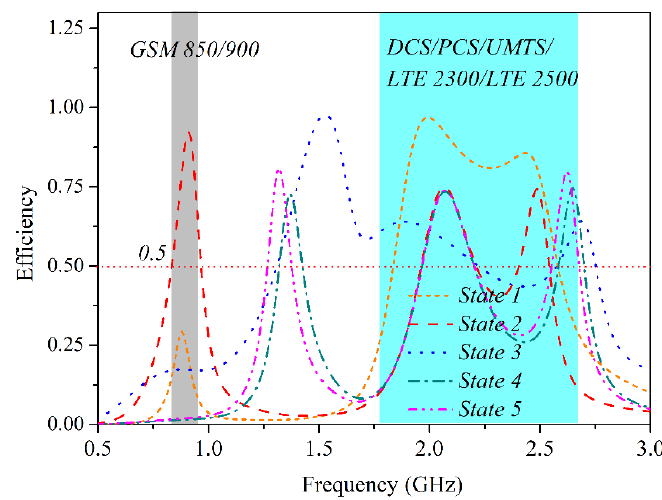
Figure 8. Five |S 11 | states of the proposed T-shaped antenna: State 2 for lower bands and the other four states for mid and high bands.